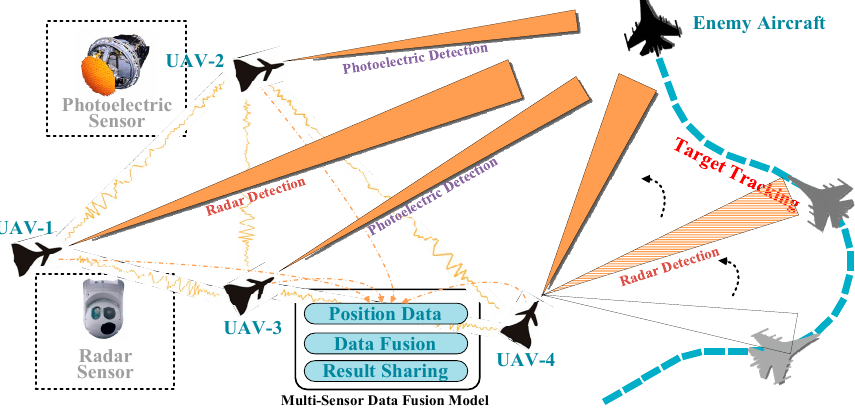
Figure 1. The scene of multisensor data fusion for tracking a maneuvering target in air combat. To solve the problem of data fusion of multisensors for tracking of enemy aircraft, this paper puts forward several assumptions.